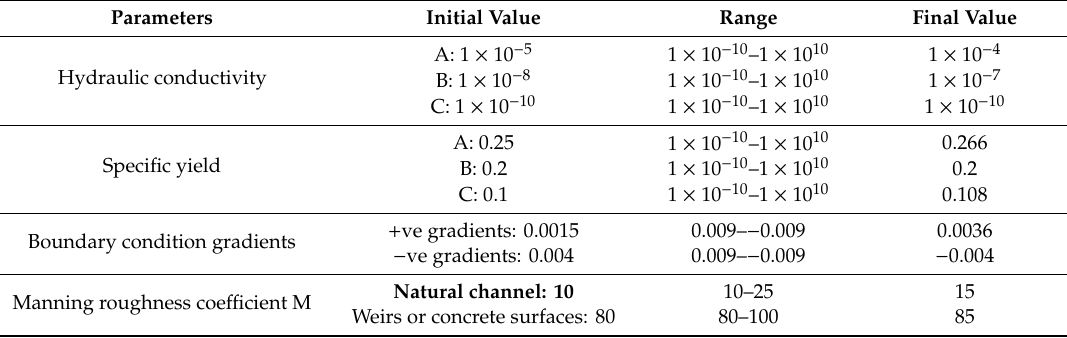
Table 5. Parameters used for calibration and their range and selected